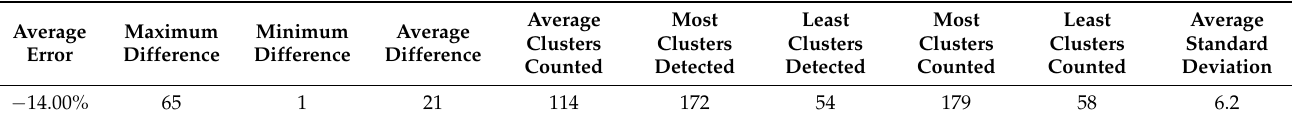
Table 3. Average results obtained for both sides of the orchard